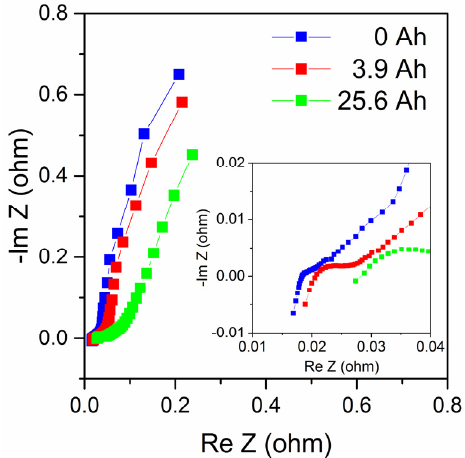
Figure 9. Impedance measurements for cell 1 showing real vs. imagined part three times: the beginning of life (0 Ah), intermediate measurement (3.9 Ah), and at the end of the testing (25.6 Ah), with a magnification around the origin in the inset.